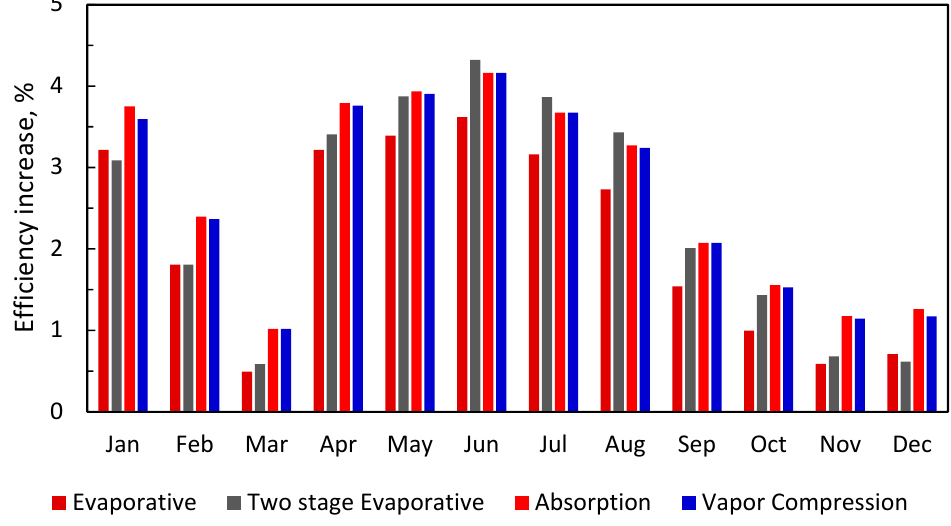
Figure 16. Percentage increase in gas turbine efficiency.